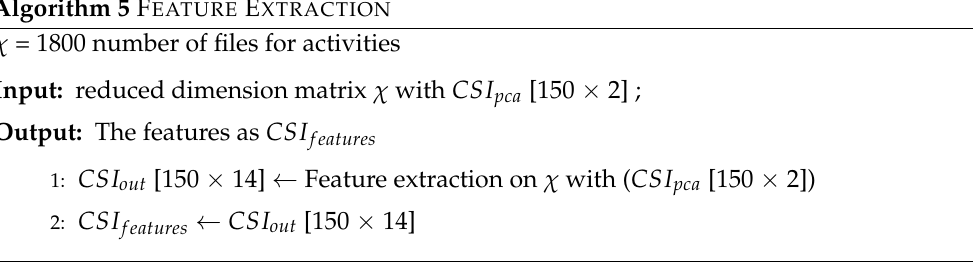
Algorithm 5 F EATURE E XTRACTION